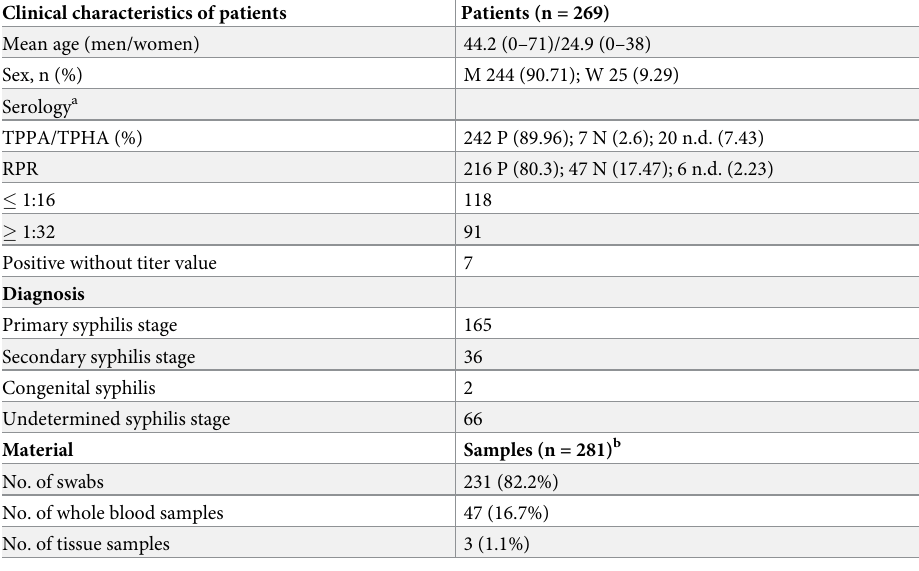
Table 1. Clinical characteristics of patients with typed TPA samples. Clinical characteristics of